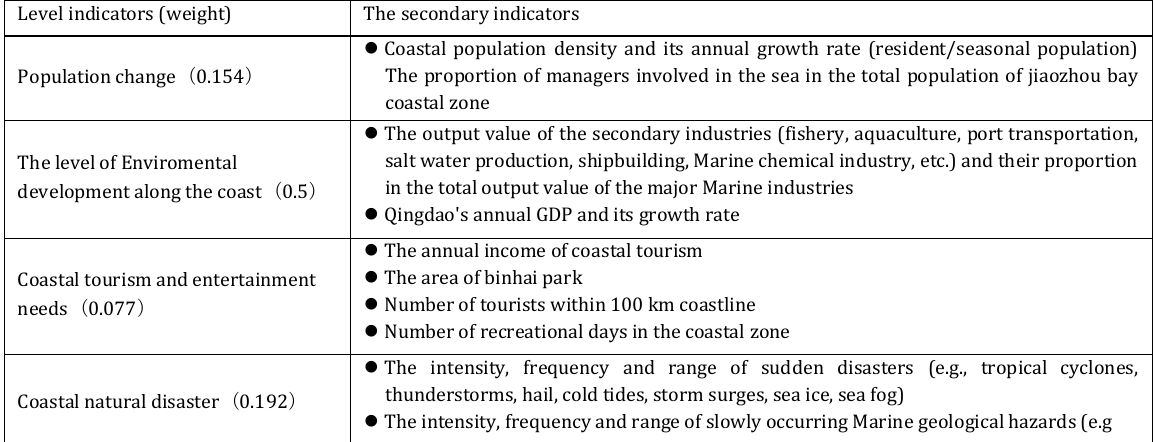
Table 1: The Indicator System for EBCZM of Jiaozhou Bay (Driver: 4 kinds) Level indicators (weight) The secondary indicators Population change （ 0.154